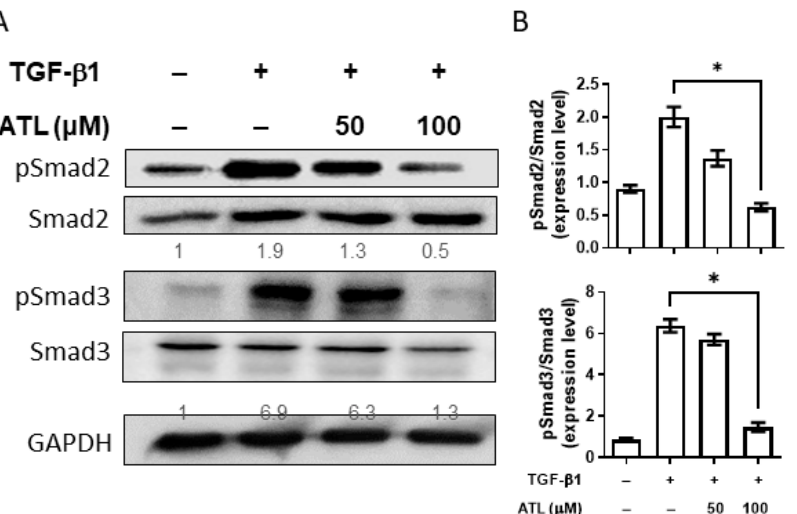
Figure 4. Atractylodin suppressed Smad-dependent pathway activation triggered by TGF- β 1 in A549 cells. A549 cells were pretreated with ATL for 1 h followed by TGF- β 1 (2 ng/mL) stimulation for an additional 6 h. Cells treated with DMSO were set up as the control group. ( A ) Protein expression levels of p-Smad2, p-Smad3, Smad2, and Smad3 were measured by Western blot assay. ( B ) Quantitation of Western blot signal intensities with ImageJ software. Values represent the mean ± SEM from triplicate samples for each treatment. (*) p < 0.05 versus TGF- β 1 + 0.1% DMSO-treated control, as determined by non-parametric Kruskal–Wallis test and all pairwise multiple comparison procedures (Dunn’s Method).